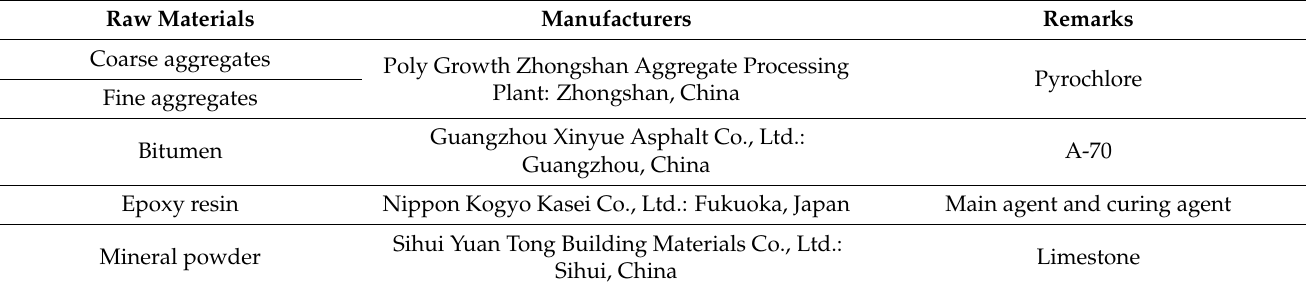
Table 2. Raw materials.